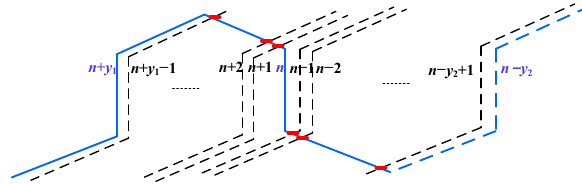
Figure 8. Position of the possible end short ‐ circuit faults.